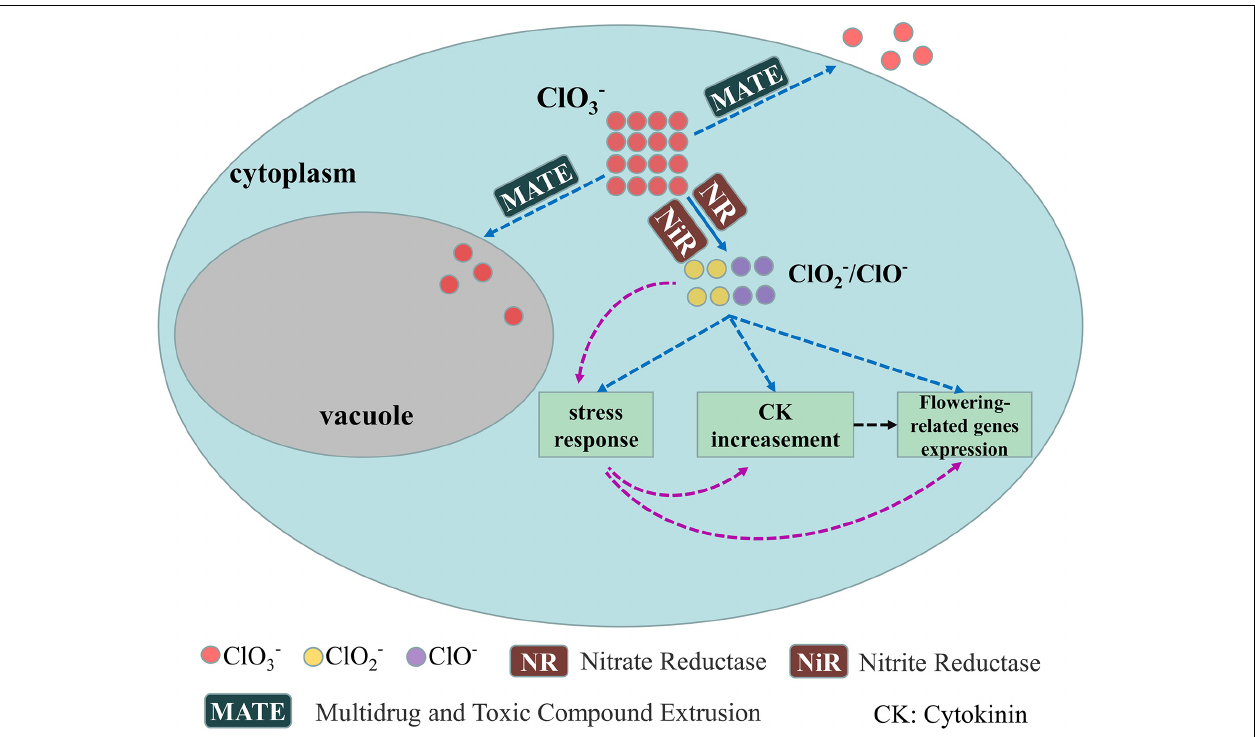
FIGURE 3 | Proposed model of the molecular regulation of KClO 3 mediated FI. The solid line shows confirmed result while dotted lines indicate speculated. Blue dotted lines (after ClO 2 − /ClO − ): ClO 2 − /ClO − may directly induce stress response, CK content increasement and flowering-related genes expression; Red dotted lines: ClO 2 − /ClO − induce stress response, then stress response induce CK content increasement and flowering-related genes expression; Black dotted line: CK content increasement may also induce flowering-related genes